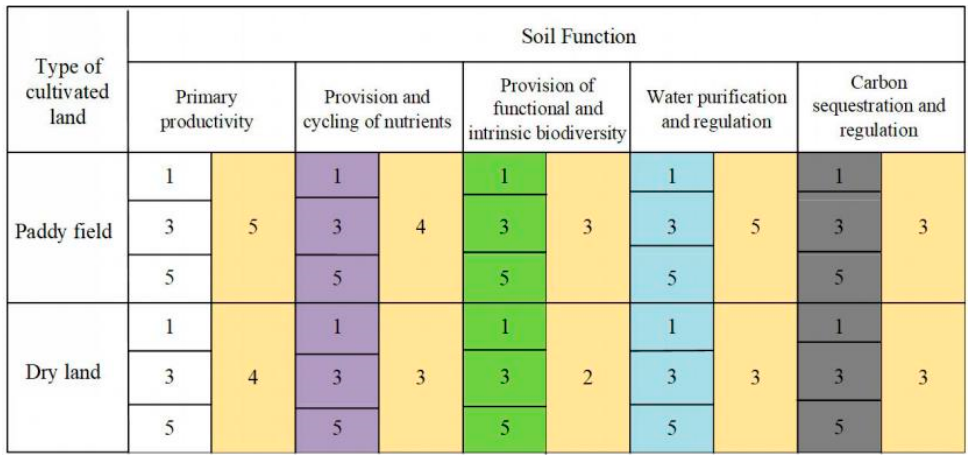
Figure 4. Soil function supply matrix of cultivated land in Heilongjiang province.